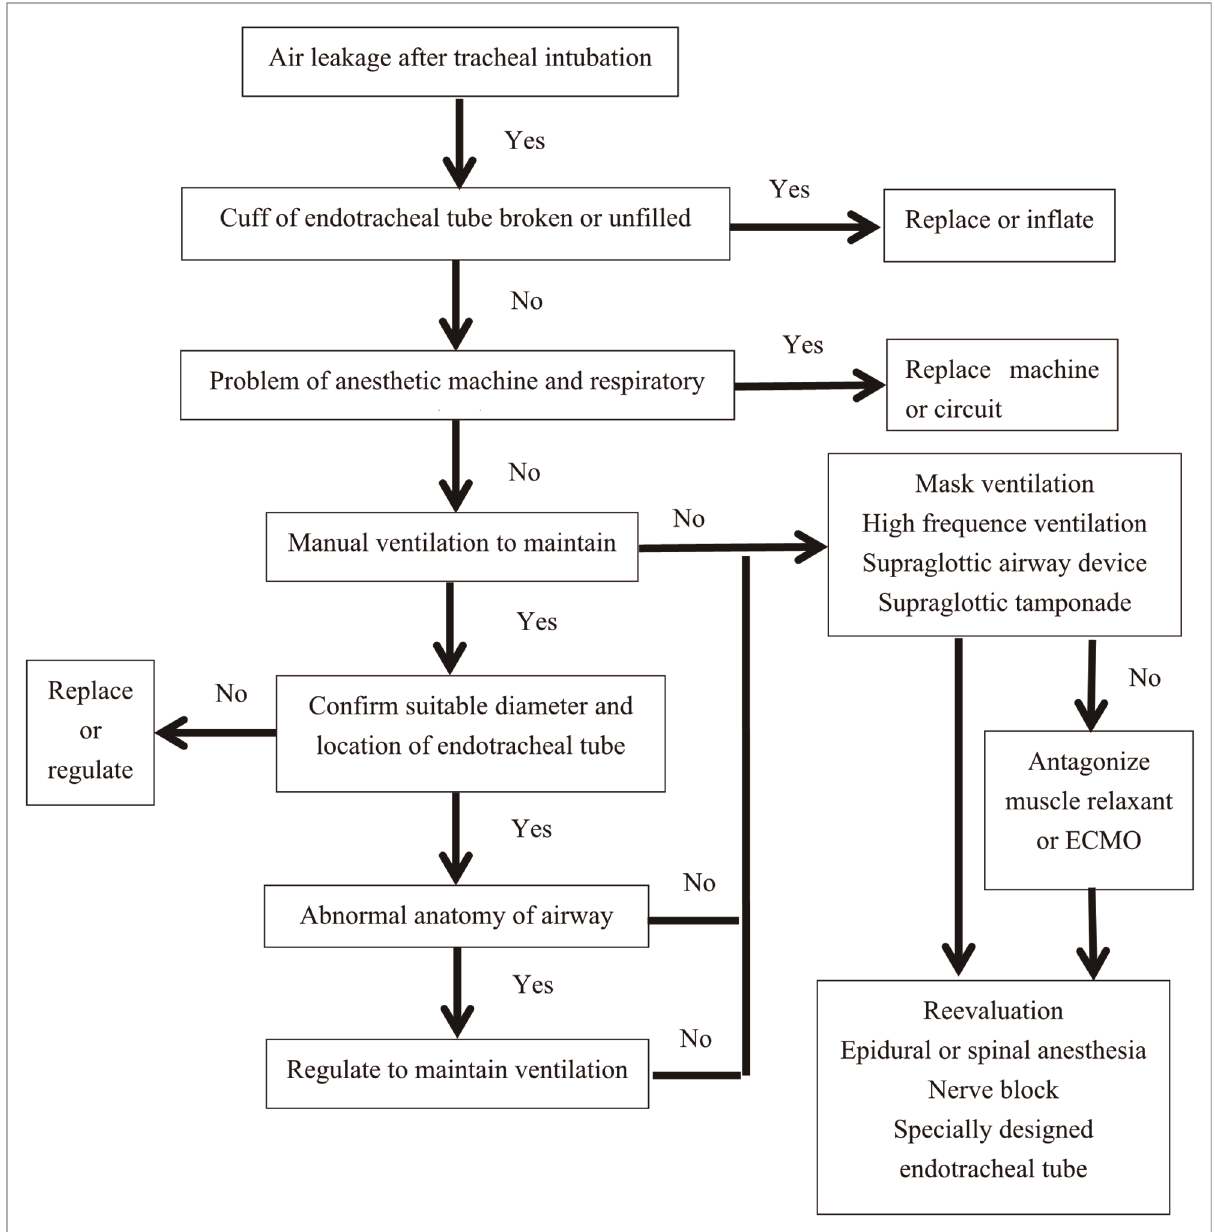
FIGURE 4 Protocol dealing with air leakage after endotracheal intubation. ECMO, extracorporeal membrane